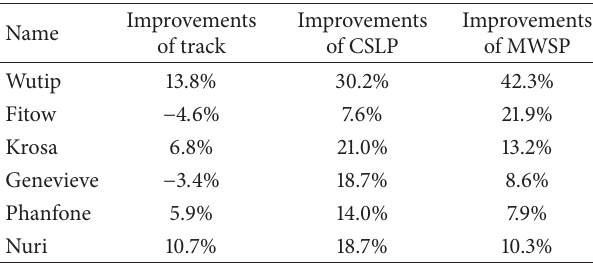
Table 3: Improvements of track, CSLP, and MWSP by the vortex initialization scheme.